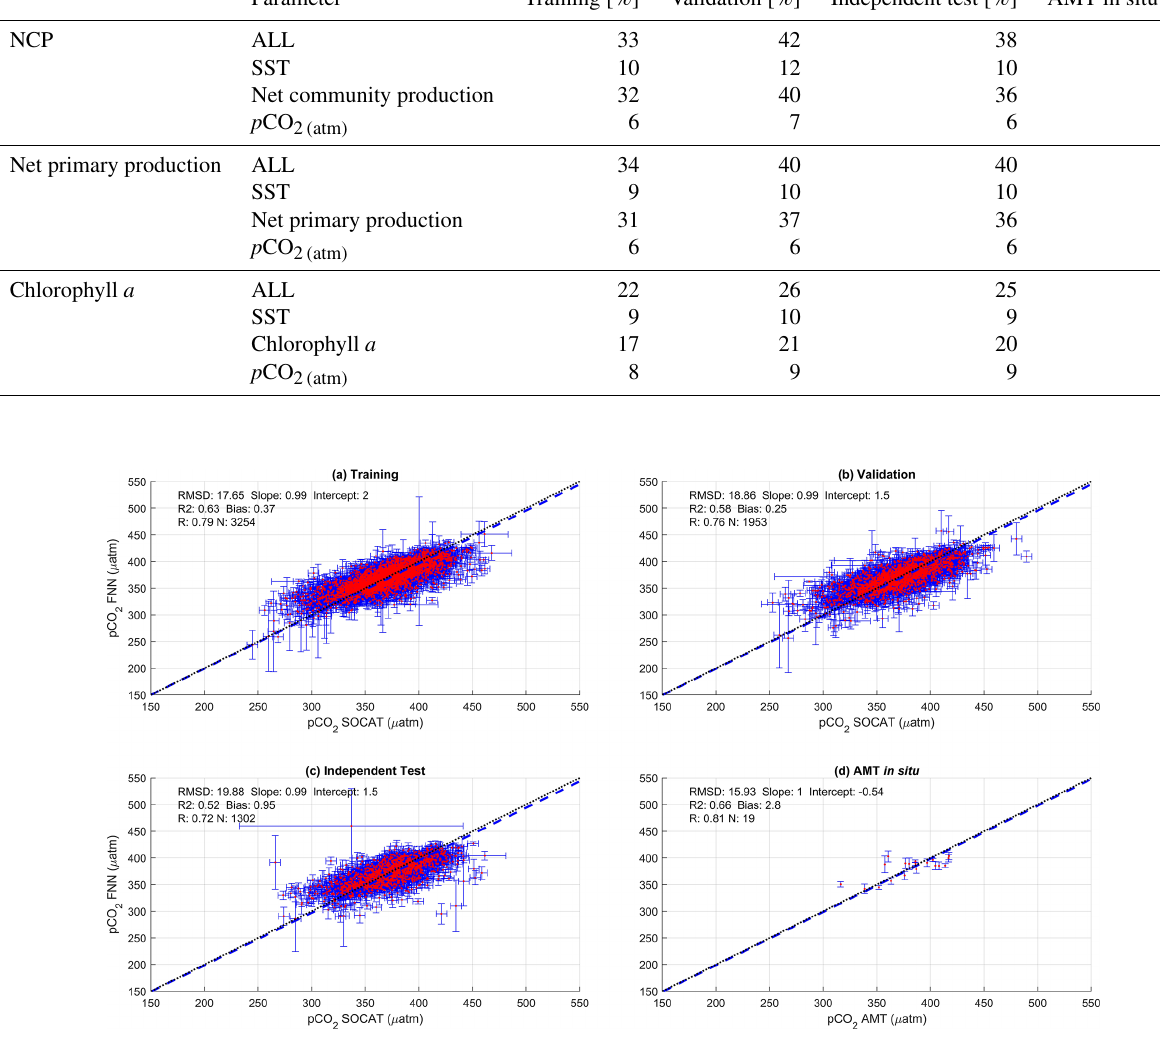
Figure A1. Scatter plots showing the combined performance of the eight feed forward neural networks trained using chlorophyll a for four separate training and validation datasets: (a) training, (b) validation, (c) independent test and (d) Atlantic Meridional Transect (AMT) in situ. The blue dashed line is the type II regression, and the black dashed line is the 1 : 1 line. Horizontal error bars indicate the uncertainty of the SOCATv2020 p CO 2 ( sw ) . Vertical error bars indicate the uncertainty attributed to the input parameter uncertainty propagated through the feed forward neural networks. The statistics within each plot are the root mean square difference (RMSD), slope and intercept of the type II regression, coefficient of determination ( R 2 ), Pearson correlation coefficient ( R ), bias and number of samples ( N